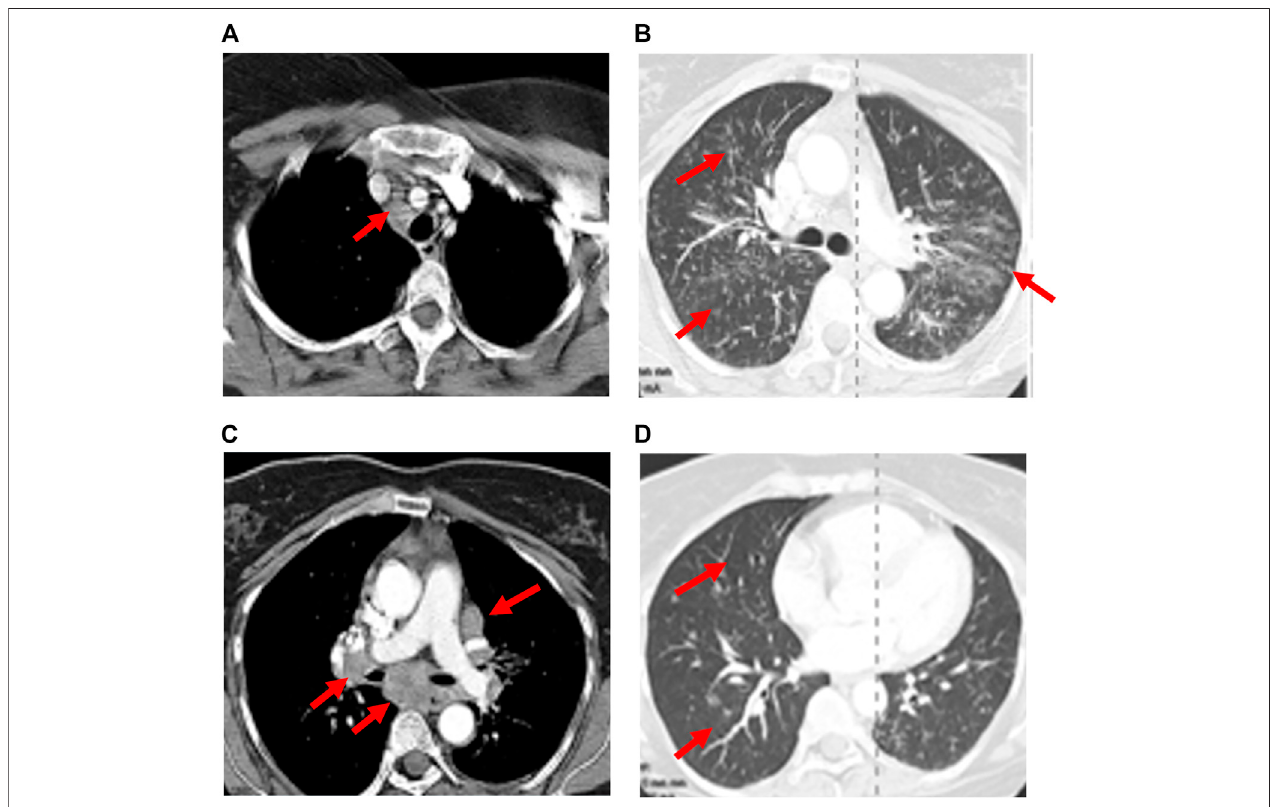
FIGURE 2 | Recrudescence of pneumonitis with drug rechallenge. A 47-year-old man presented with dry cough and dyspnea 11 weeks after initiation of Nivolumab for treatment of non-Hodgkin lymphoma. CT scan showed patchy bilateral ground glass changes (A,D) . Bronchoscopy with biopsy con fi rmed organizing pneumonia associated with grade IIpneumonitisand thepatient wasstartedonhigh dose steroids. Clinical and radiographic improvement wasseen 6 weeks later after tapering off steroids (B,E) . Nivolumab was resumed. Three weeks later, the patient returned with increased respiratory symptoms and hypoxia. CT imaging demonstrated bilateral in fi ltrates which were worse than initial presentation (C,F)